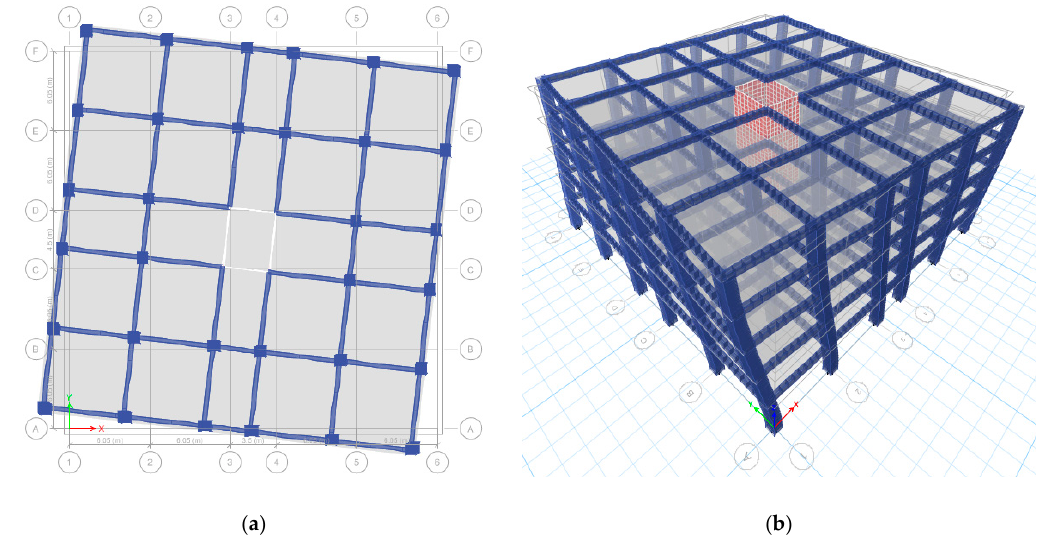
Figure 15. The 1st mode shape for T 1 = 0.389 s before the reducing of the torsion: ( a ) plane view, and ( b ) 3D view.